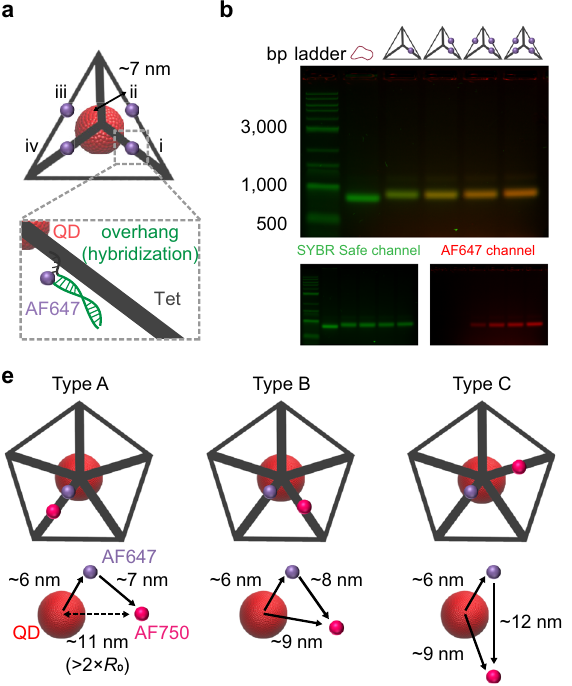
(* P <0.05); all P values are provided in Supplementary Table 3. e Schematics of three types of Pep-QD-based multi-step FRET networks and predictions of dis- tances between initial donor (QD), relay (AF647), and acceptor (AF750). f QD quenchingef fi cienciesand g AF647quenchingef fi cienciescalculatedfromthePep- QD based multi-step FRET networks (darker bar), and Förster theory (lighter bar) (Eqs.(6) – (13)).Errorbarsin d , f , g represent standard deviations of themean( n =3 replicates per group). Source data are provided as Source Data fi